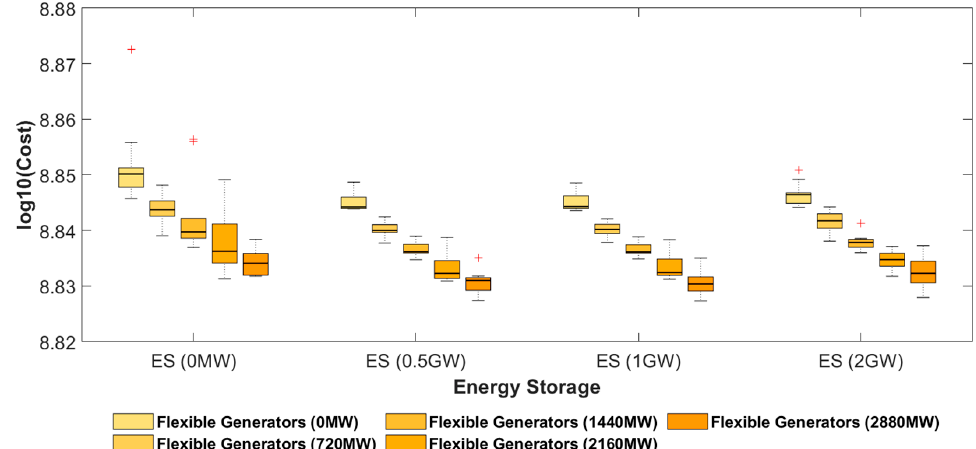
Figure 16. Cost comparison of multi-scenario unit-scheduling in winter.